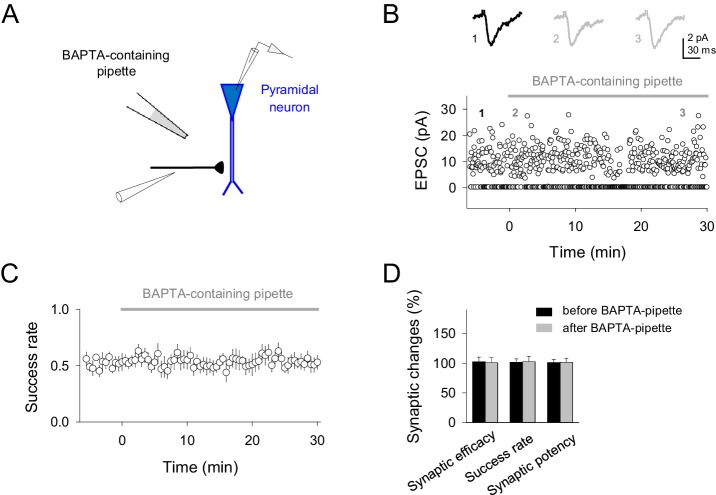
BAPTA-containing pipette in the extracellular space does not affect synaptic responses.(A) Schematic experimental design showing the single synapse stimulation, neuronal recording and BAPTA-containing pipette location. (B) Representative EPSCs before and after different time points placing the BAPTA-containing pipette at the slice (top; gray bar) and temporal course of single synapse activity in the presence of BAPTA-containing pipette (bottom). (C) Average success rate values from different experiments (n = 10 synapses). (D) Relative changes of synaptic parameters relative to basal before (black) and after placing BAPTA-containing pipette (gray bars; n = 10). Note that absence of synaptic effects after buffering Ca2+ into astrocytes were not caused by the leakage of BAPTA in extracellular space and buffering Ca2+, thus reducing transmitter release, because the presence of the BAPTA-containing patch pipette for 30 min in slices did not affect synaptic parameters (Synaptic efficacy, p=0.887; Success rate, p=0.938; Synaptic potency, p=0.923). Error bars indicate SEM.